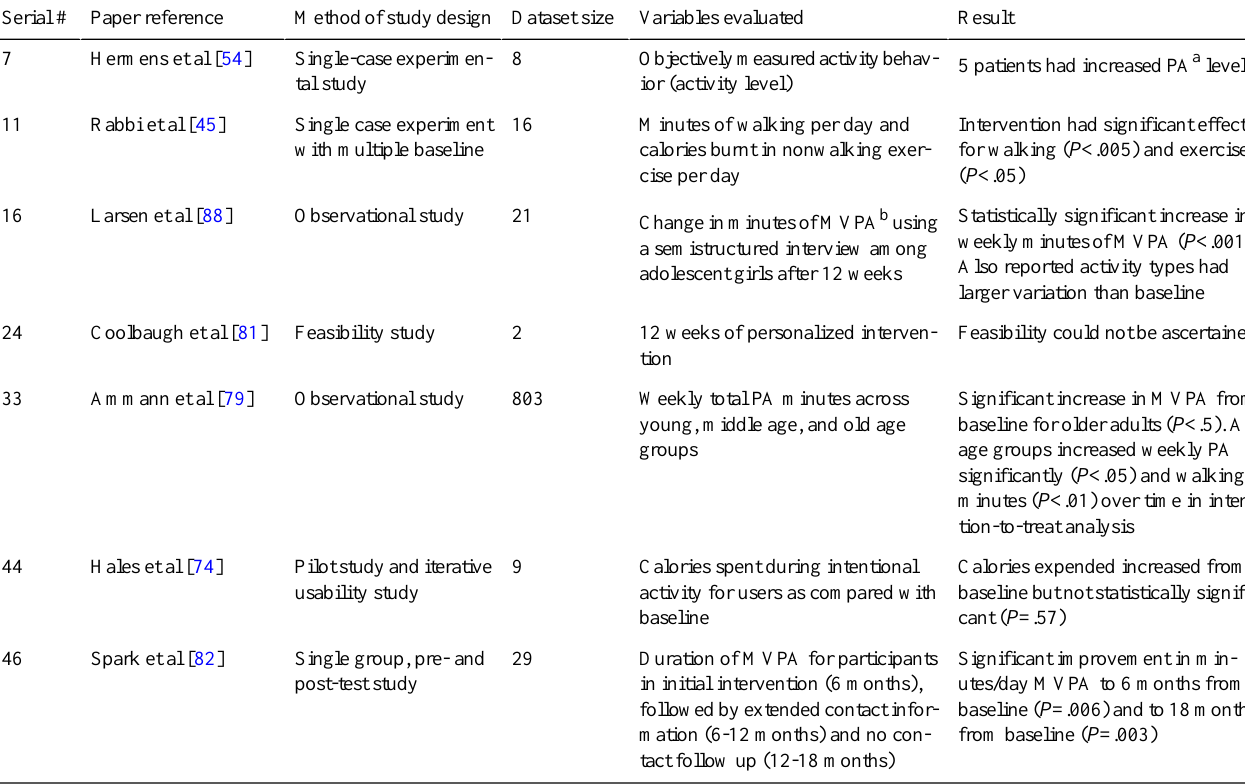
Table 4. Results of individual studies—nonrandomized controlled